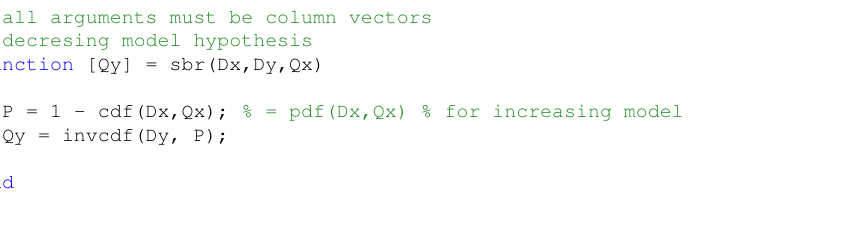
Figure A3. MATLAB code used to implement the proposed SBR